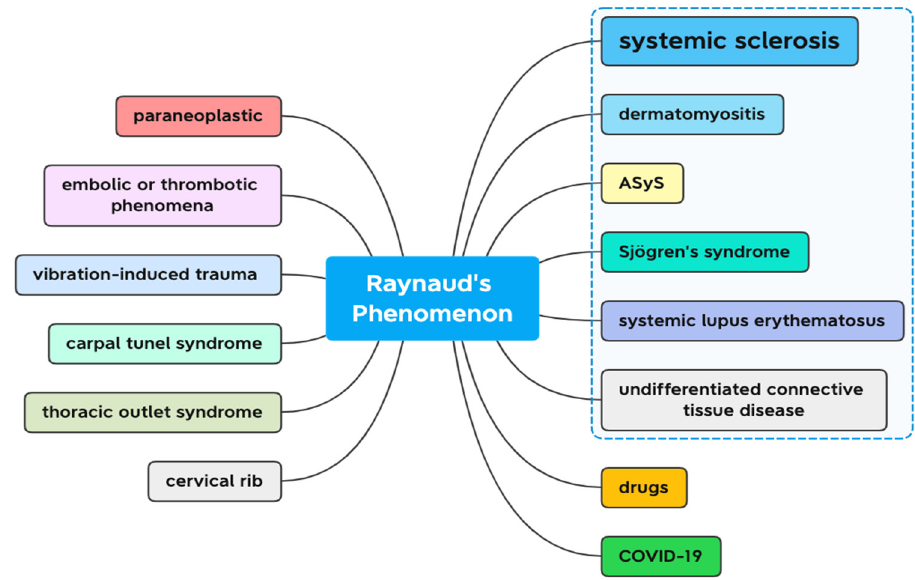
Figure 1. Secondary causes of Raynaud’s phenomenon. Blue dashed line—connective tissue diseases; ASyS—antisynthetase syndrome. Table 2. Raynaud’s phenomenon—proposed laboratory tests [16,17]. TPO—thyroid peroxidase; TG—thyroglobulin; ANA—antinuclear